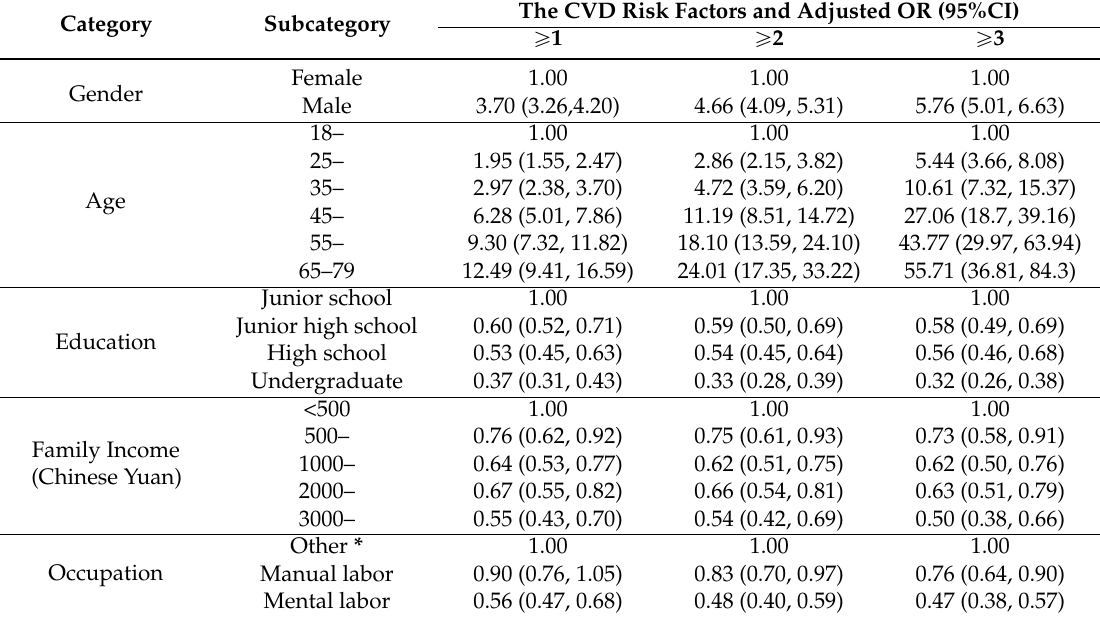
Table 5. The logistic analysis of the CVD risk factor clustering among